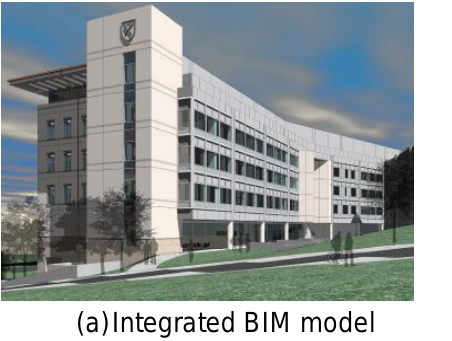
Figure 7 Use of BIM in the project preconstruction stage (Courtesy of: Holder Construction Company, Atlanta,